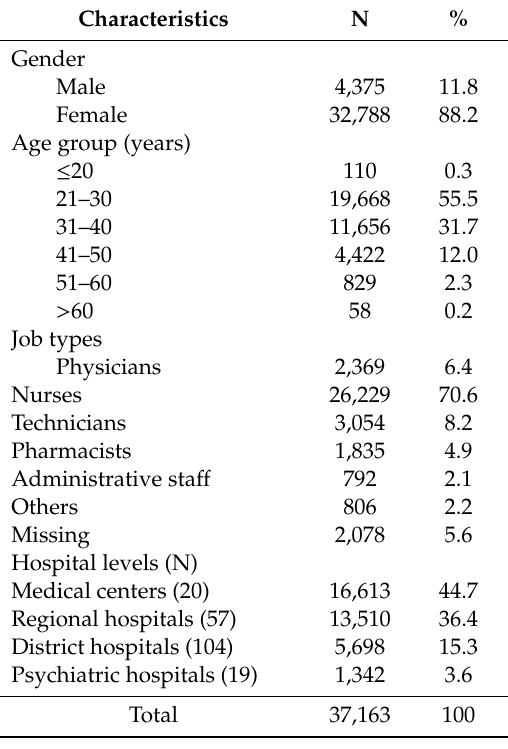
Table 1. Characteristics of